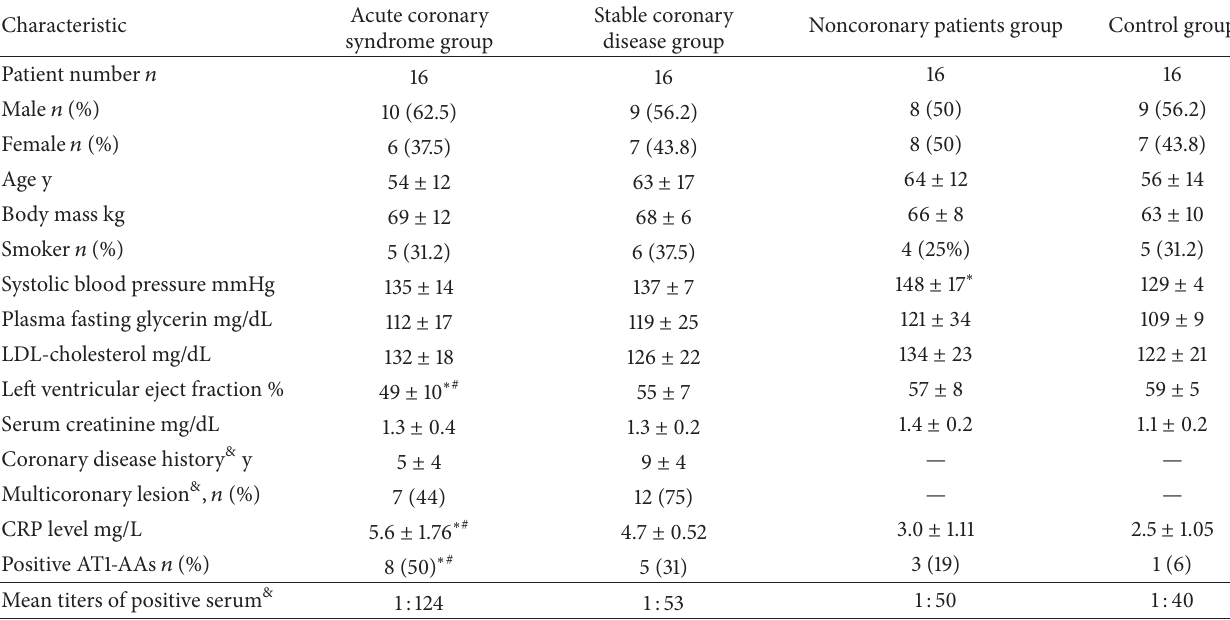
Table 1: Main clinical features of enrolled patients and levels of CRP and AT1-AAs.